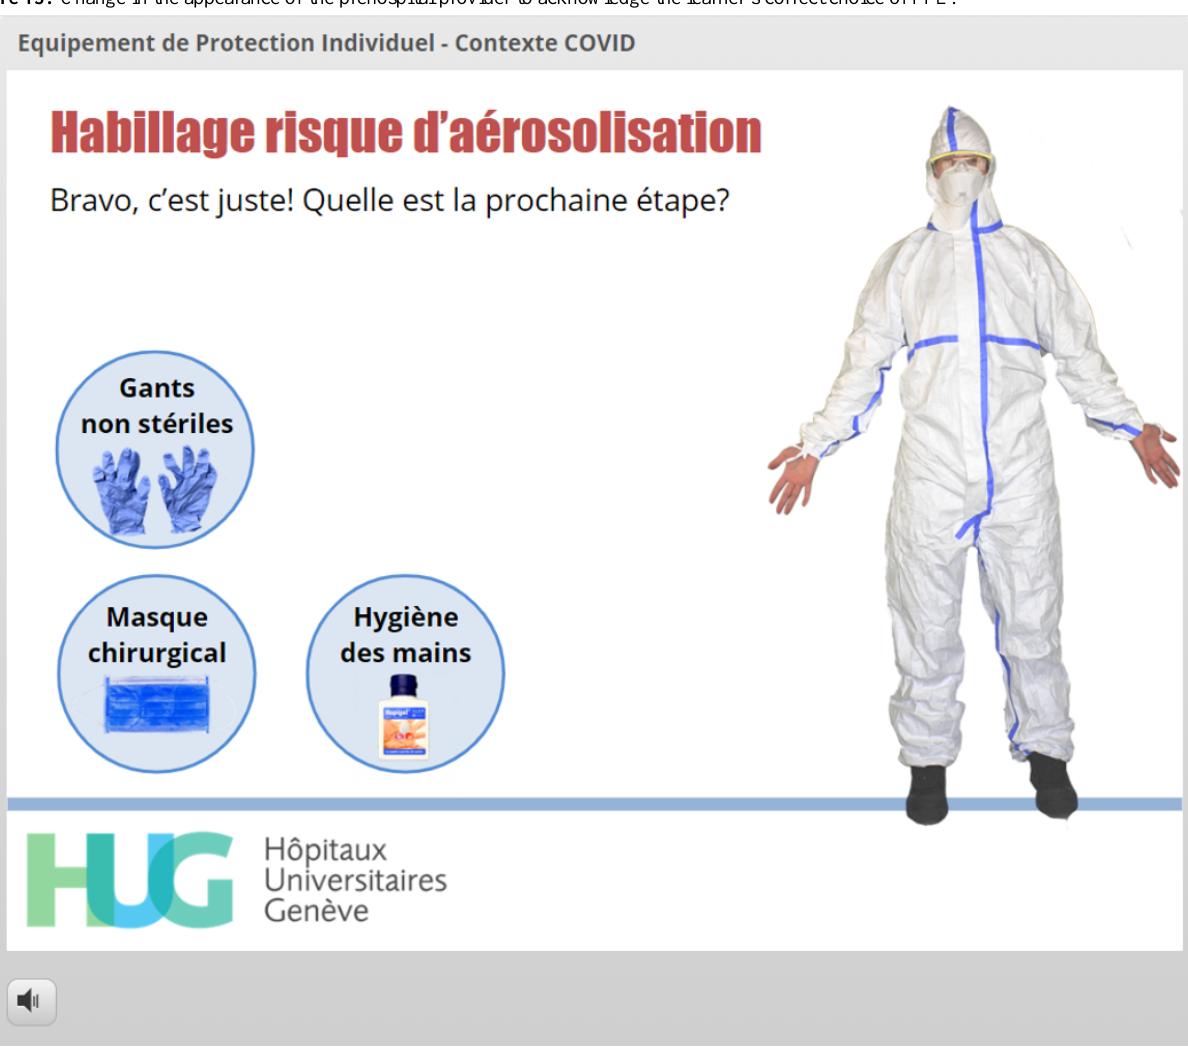
Figure 13. Change in the appearance of the prehospital provider to acknowledge the learner’s correct choice of